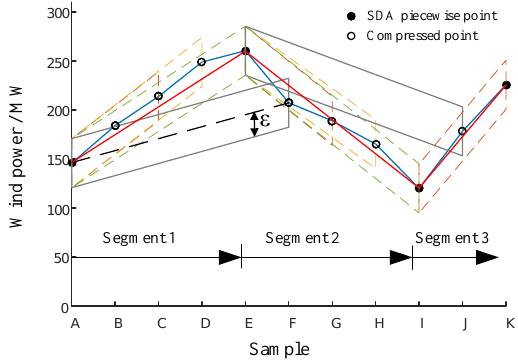
Figure 2. The basic principle of the Swinging Door Algorithm (SDA).